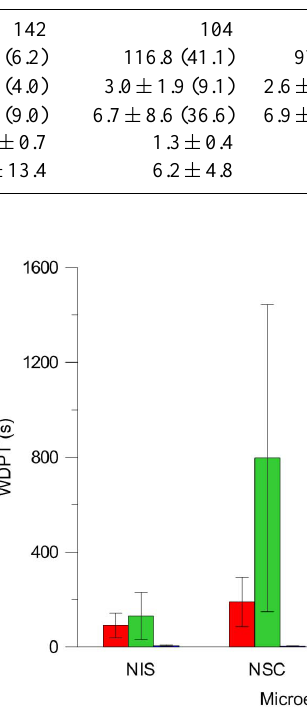
Fig. 2. SWR measured for every microenvironment and season. Error bars represent standard deviation. NIS: north-facing inter- shrub; NSC: north-facing shrub-covered; SIS: south-facing inter- shrub; SSC: south-facing